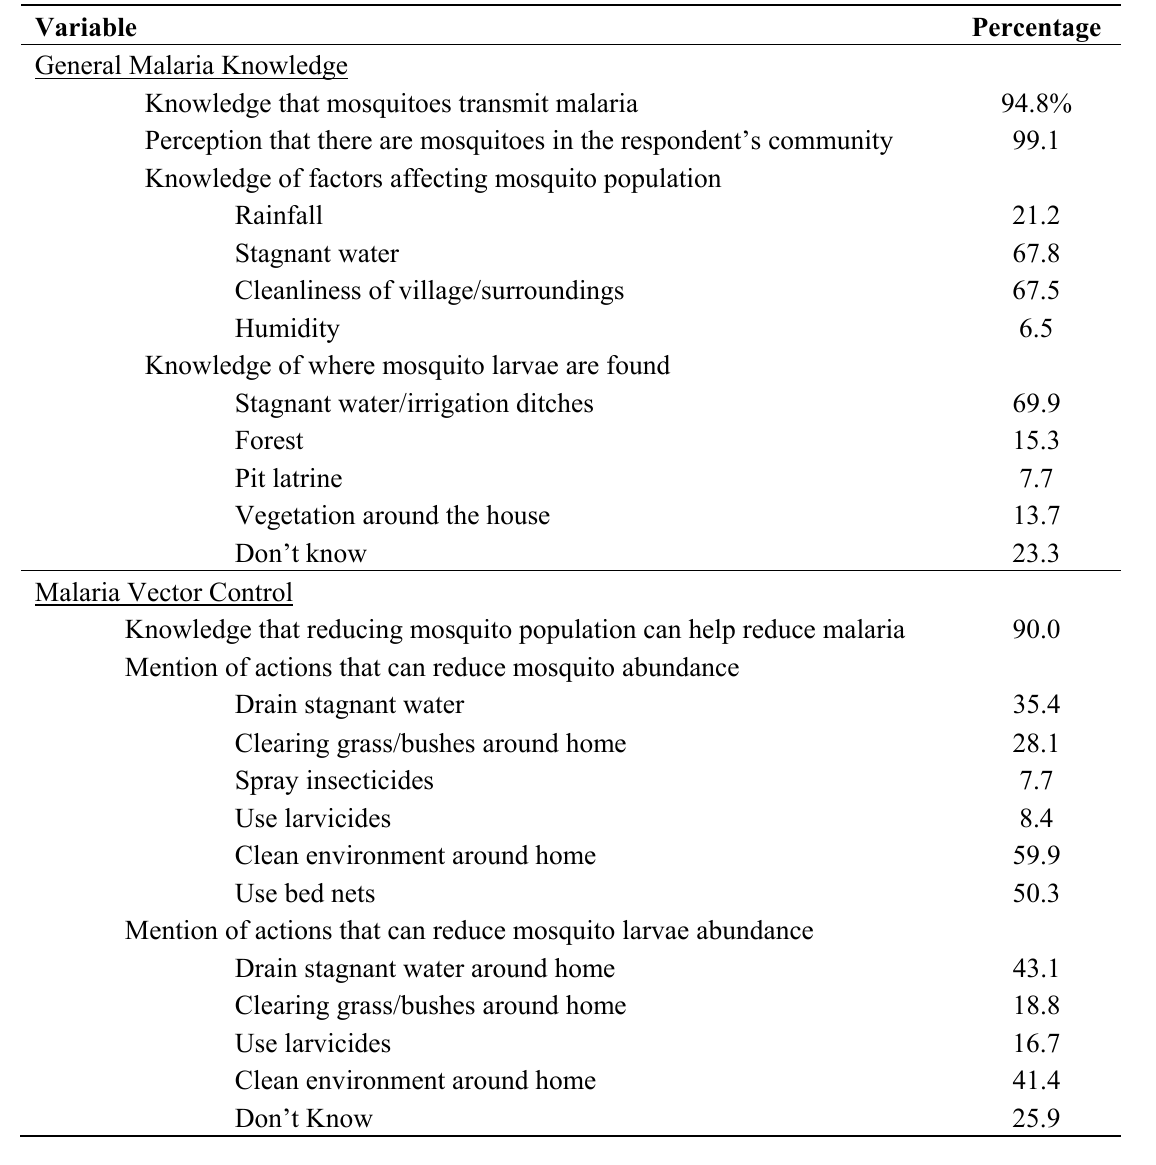
Table 2. Knowledge, attitudes, and perceptions on malaria and vector